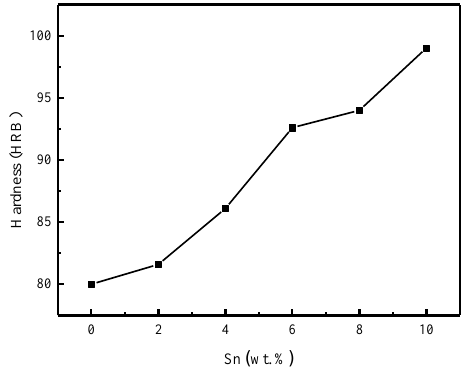
Figure 6. The hardness of the matrix of sintered samples with different Sn contents.